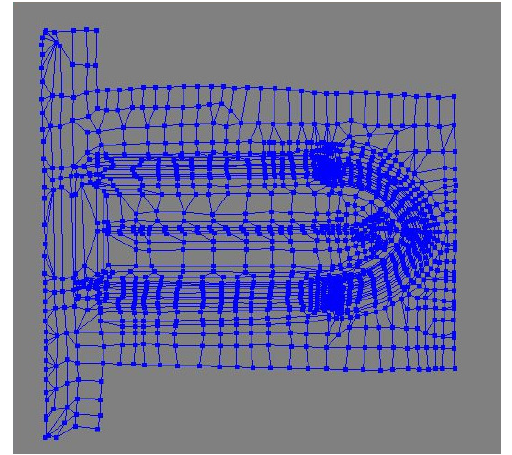
Figure 10: The development of part of the mesh This is achieved using a Matlab script that was developed at the Laboratory of Photogrammetry. The algorithm employed actually utilizes the orientation parameters of a given image and the collinearity equation in order to isolate the area of the object that is visible in an image, taking also into consideration the surface orientation in order to exclude backfacing and poorly imaged triangles, and link each of the visible TIN vertices onto that original image by means of an OBJ file. In this way, for each one of the oriented images a file containing the visible model area is created and the respective image is linked to it as its texture map.